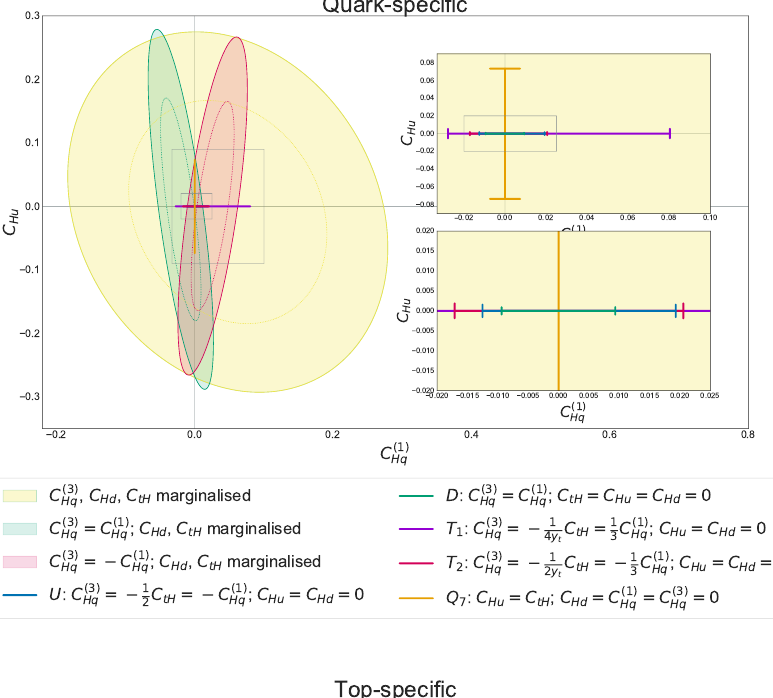
, C Hu ) in the quark-specific scenario and Hq